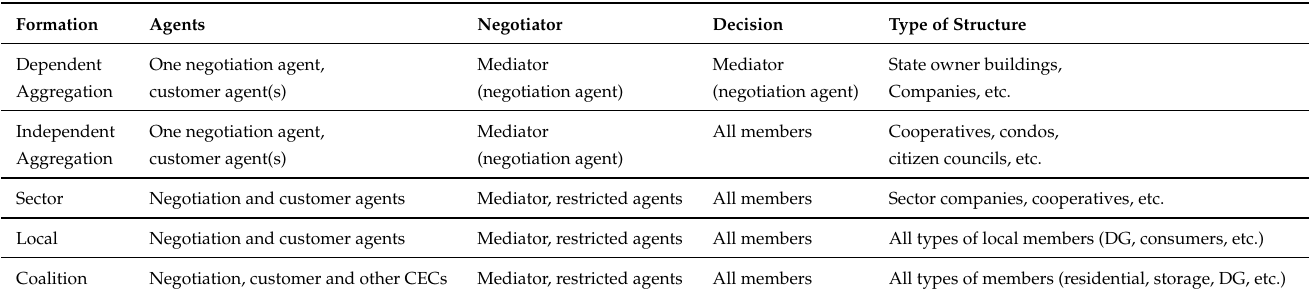
Table 1. Characteristics of the types of CEC